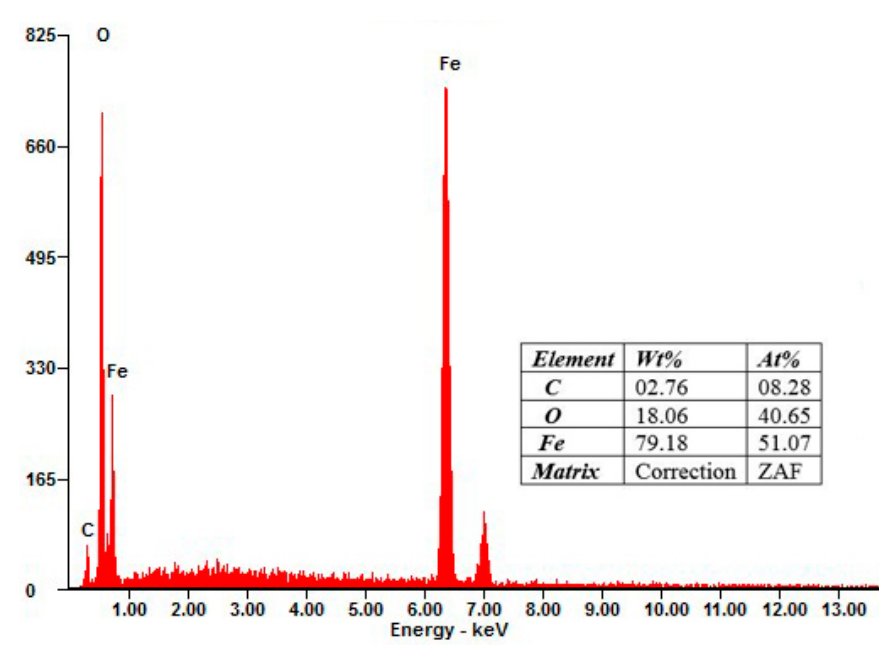
Figure 2. EDX spectrum of MGO.